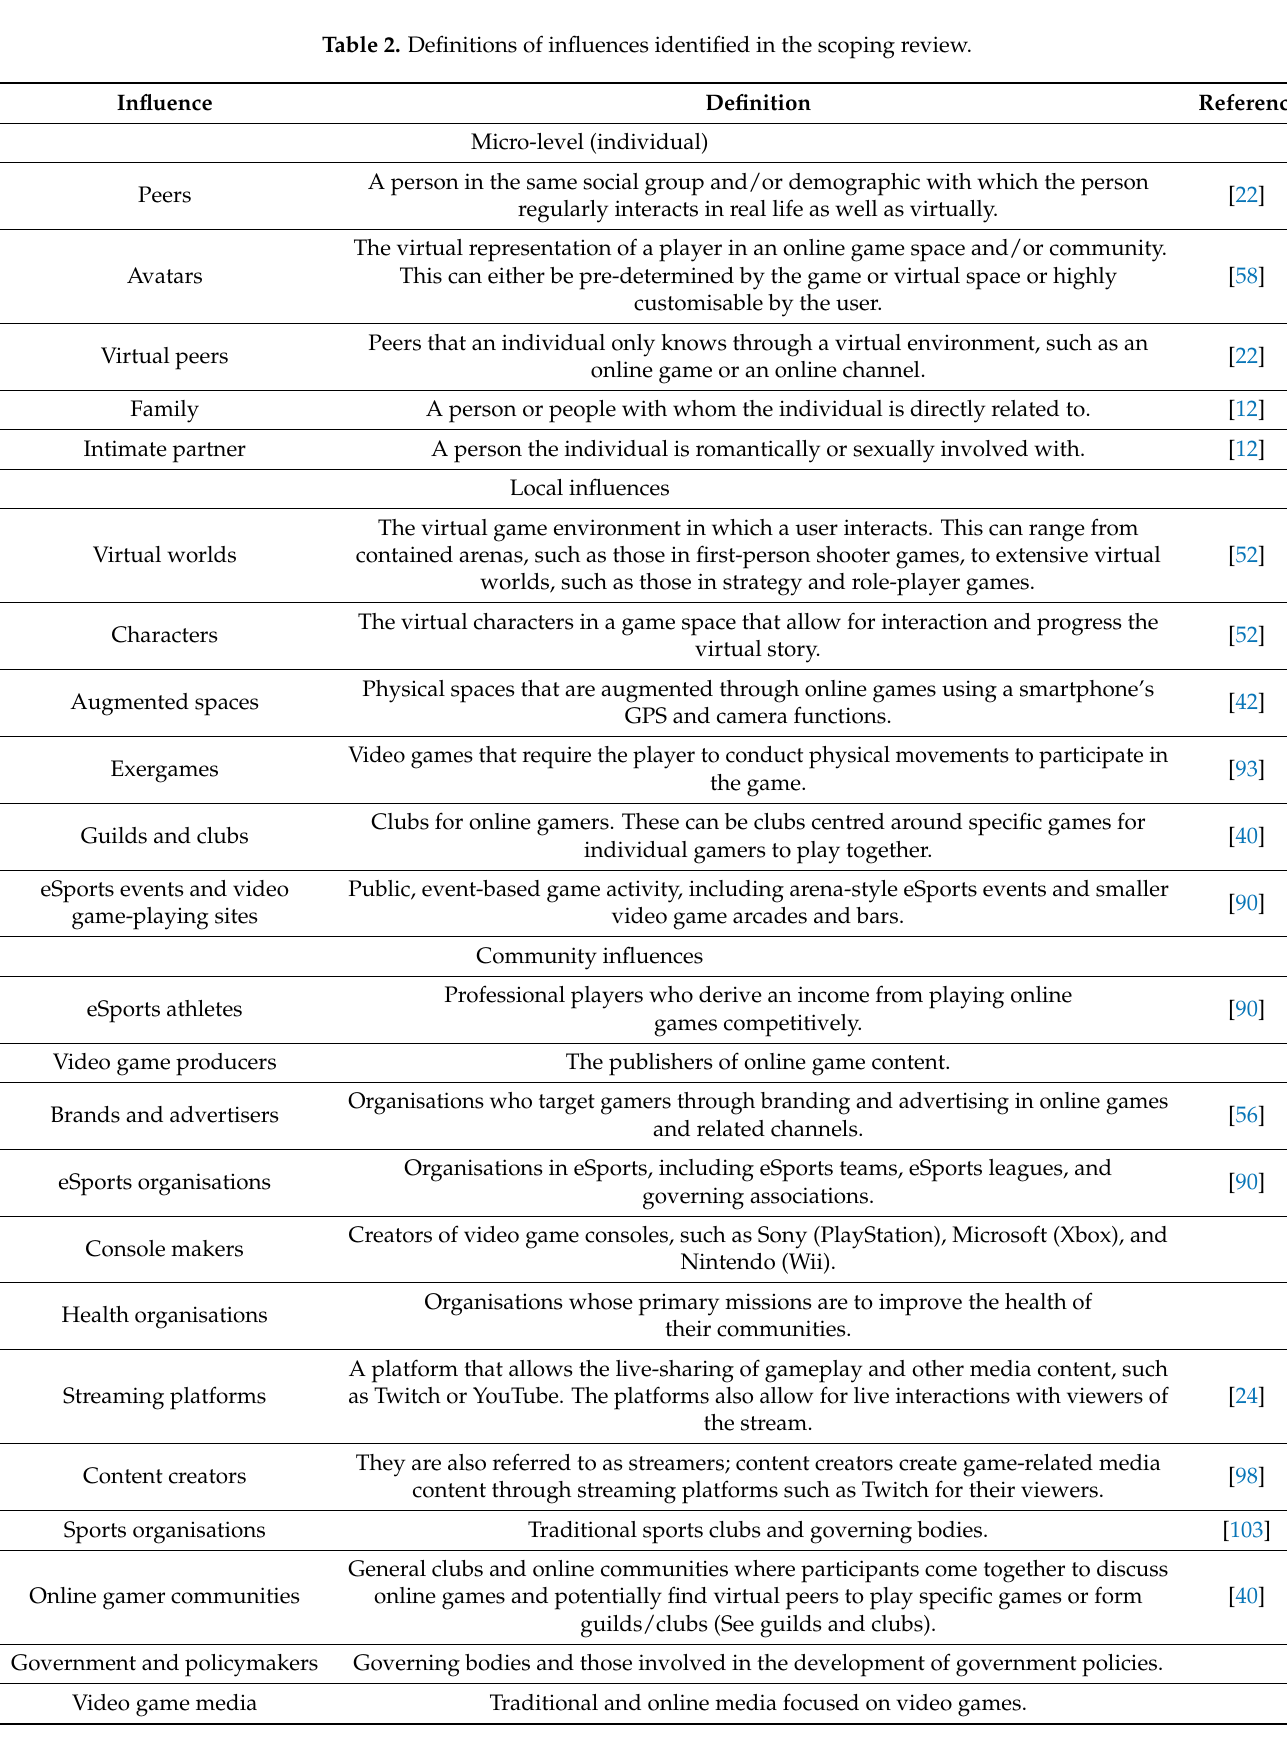
Table 2. Definitions of influences identified in the scoping